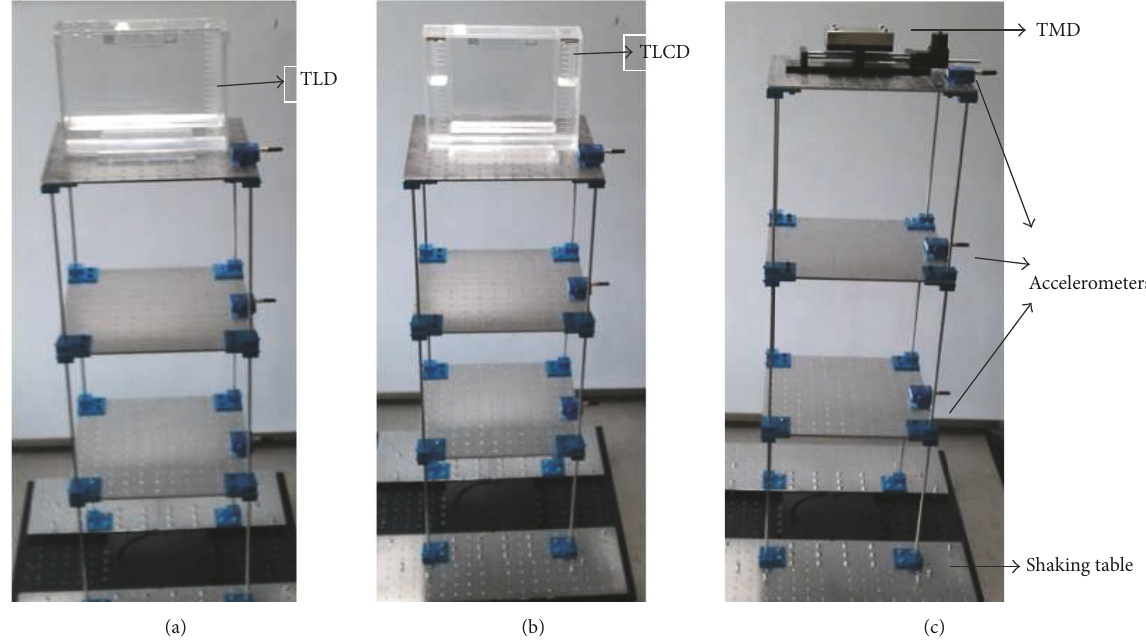
Figure 2: The experimental design for the structure-controller system, (a) TLD, (b) TLCD, and (c)